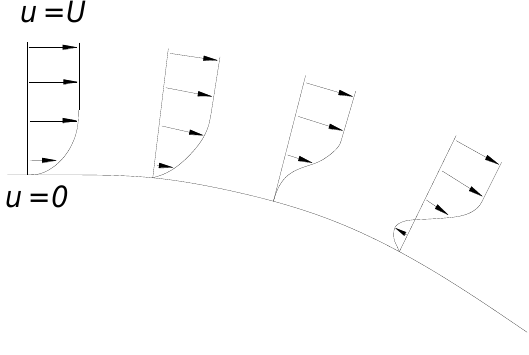
Figure 9. Velocity field at the boundary layer and flow separation (in the last profile).